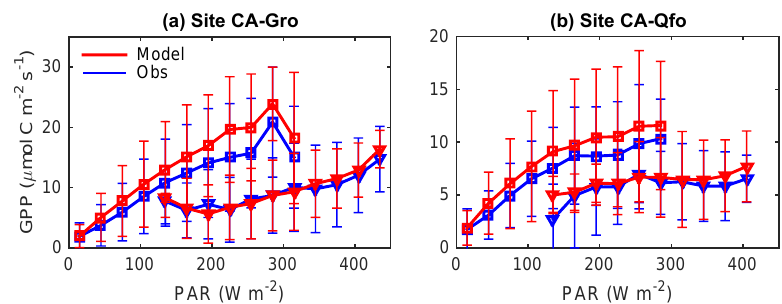
Figure 5. Observed (blue) and simulated (red) response of GPP to diffuse (square) and direct (triangle) PAR at boreal sites (a) CA-Gro (2004–2013) and (b) CA-Qfo (2004–2010). Observations and simulations are split into “diffuse” and “direct” conditions when the diffuse fraction is > 0.8 and < 0.2, respectively. Data points are then averaged over PAR bins of 30Wm − 2 with error bars indicating 1 standard deviation of GPP for each bin.